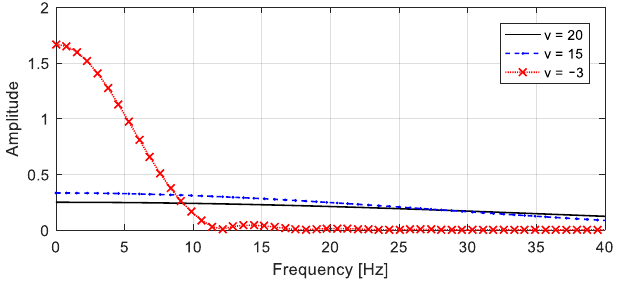
Figure 10. Frequency spectrum of the hump with velocities of [20, 15, − 3] m/s.